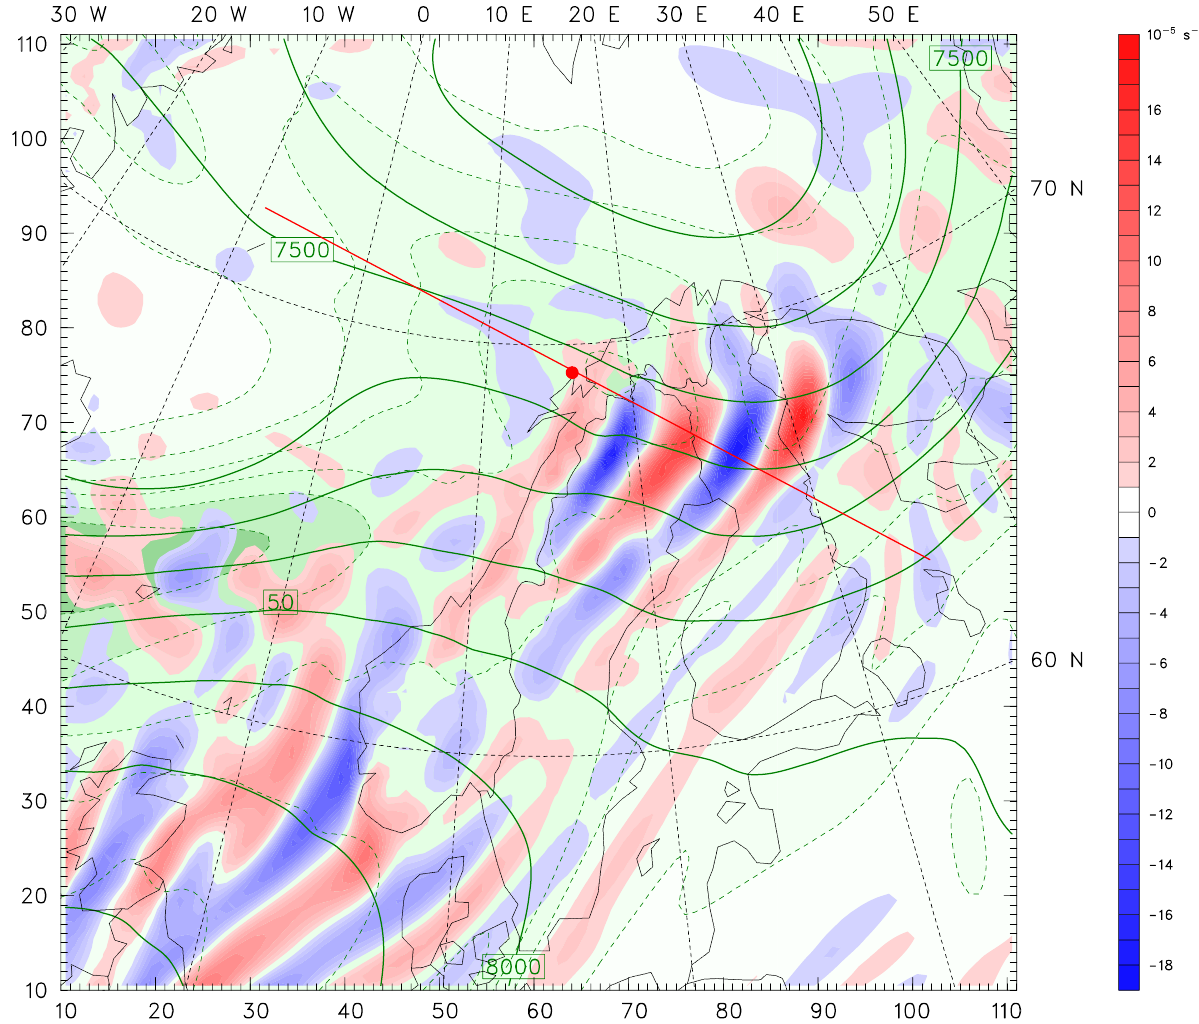
Fig. 3. Horizontal map with wind speed (dotted green) and geopotential height of 350hPa ( ∼ 8km) combined with divergence (blue/red) at 100hPa ( ∼ 16km) derived for 24 January 2003 at 04:00 UT from MM5 simulations. The red line marks the location of the vertical cross section presented in Fig. 4 with the bold dot at the position of Andenes. The upper and right axis show latitude and longitude, while left and lower axis show the number of meridional and zonal model grid points (horizontal resolution =